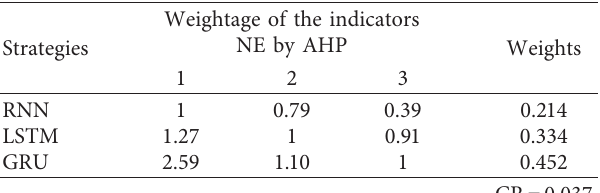
Table 17: Weightage of the indicator NF by AHP on prediction models. Weightage of the Strategies